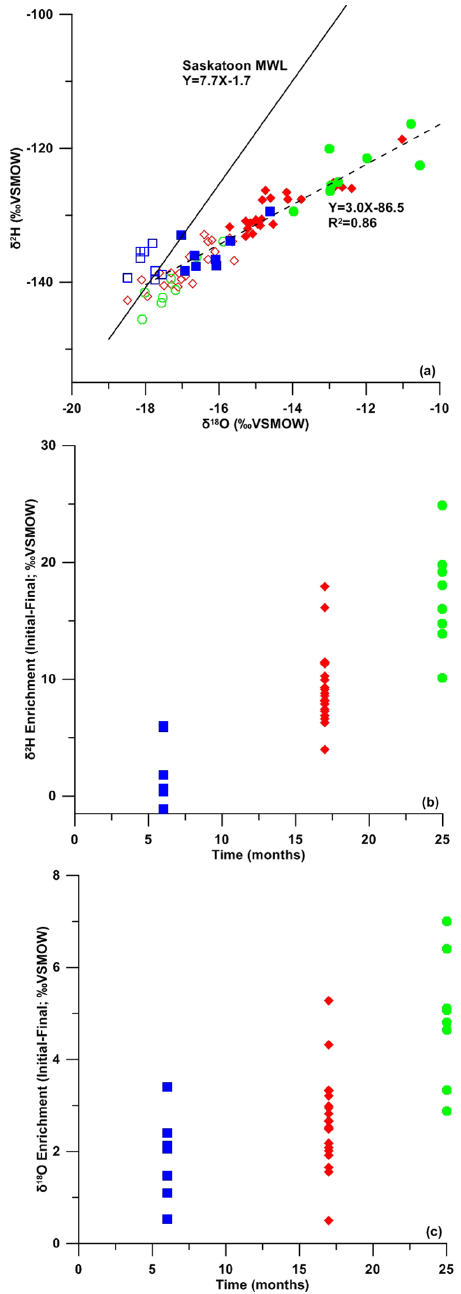
Figure 10. Effect of storage time on δ 2 H and δ 18 O of pore wa- ter in cores stored in Ziploc ™ bags: (a) cross-plot of δ 2 H and δ 18 O, (b) δ 2 H enrichment (initial minus final value) of pore water vs. stor- age time, and (c) δ 18 O enrichment (initial minus final value) of pore water vs. storage time collected from samples of glacial till. All samples were analysed within 10 days of sampling (open symbols), and after 6, 16, and 22 months of storage (solid blue squares, red di- amonds, and green circles, respectively). The solid and dashed lines in (a) represent the Saskatoon Meteoric Water Line (MWL) and the best-fit evaporation line to all data,